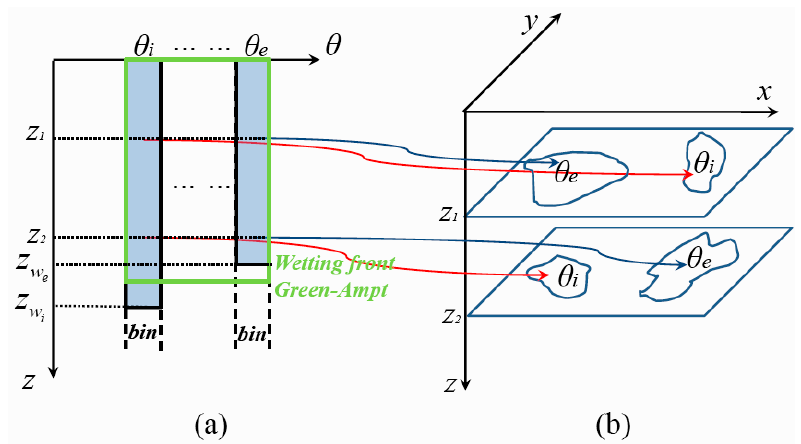
Figure 1. The mechanism in the Talbot–Ogden model. ( a ) Bins corresponding to different porosity θ -values compared to the wetting front in the Green–Ampt model; ( b ) Different moisture content in a soil over the vertical domain.